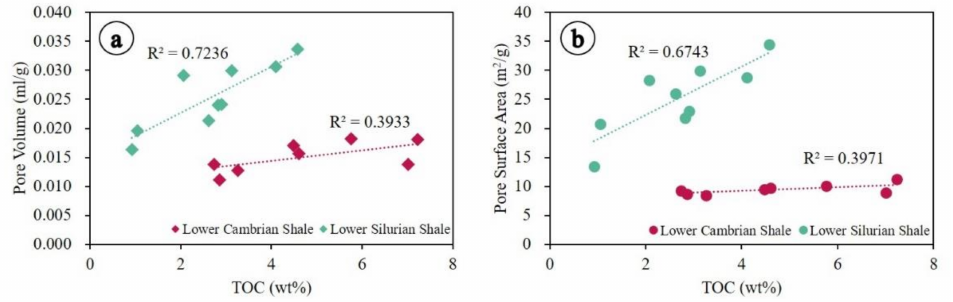
Figure 11. Scatter charts of correlations between pore properties and TOC. ( a ) Relationship between pore volume and TOC in both lower Cambrian shale and in Lower Silurian shale; and ( b ) relationship between pore surface area and TOC in both lower Cambrian shale and in lower Silurian